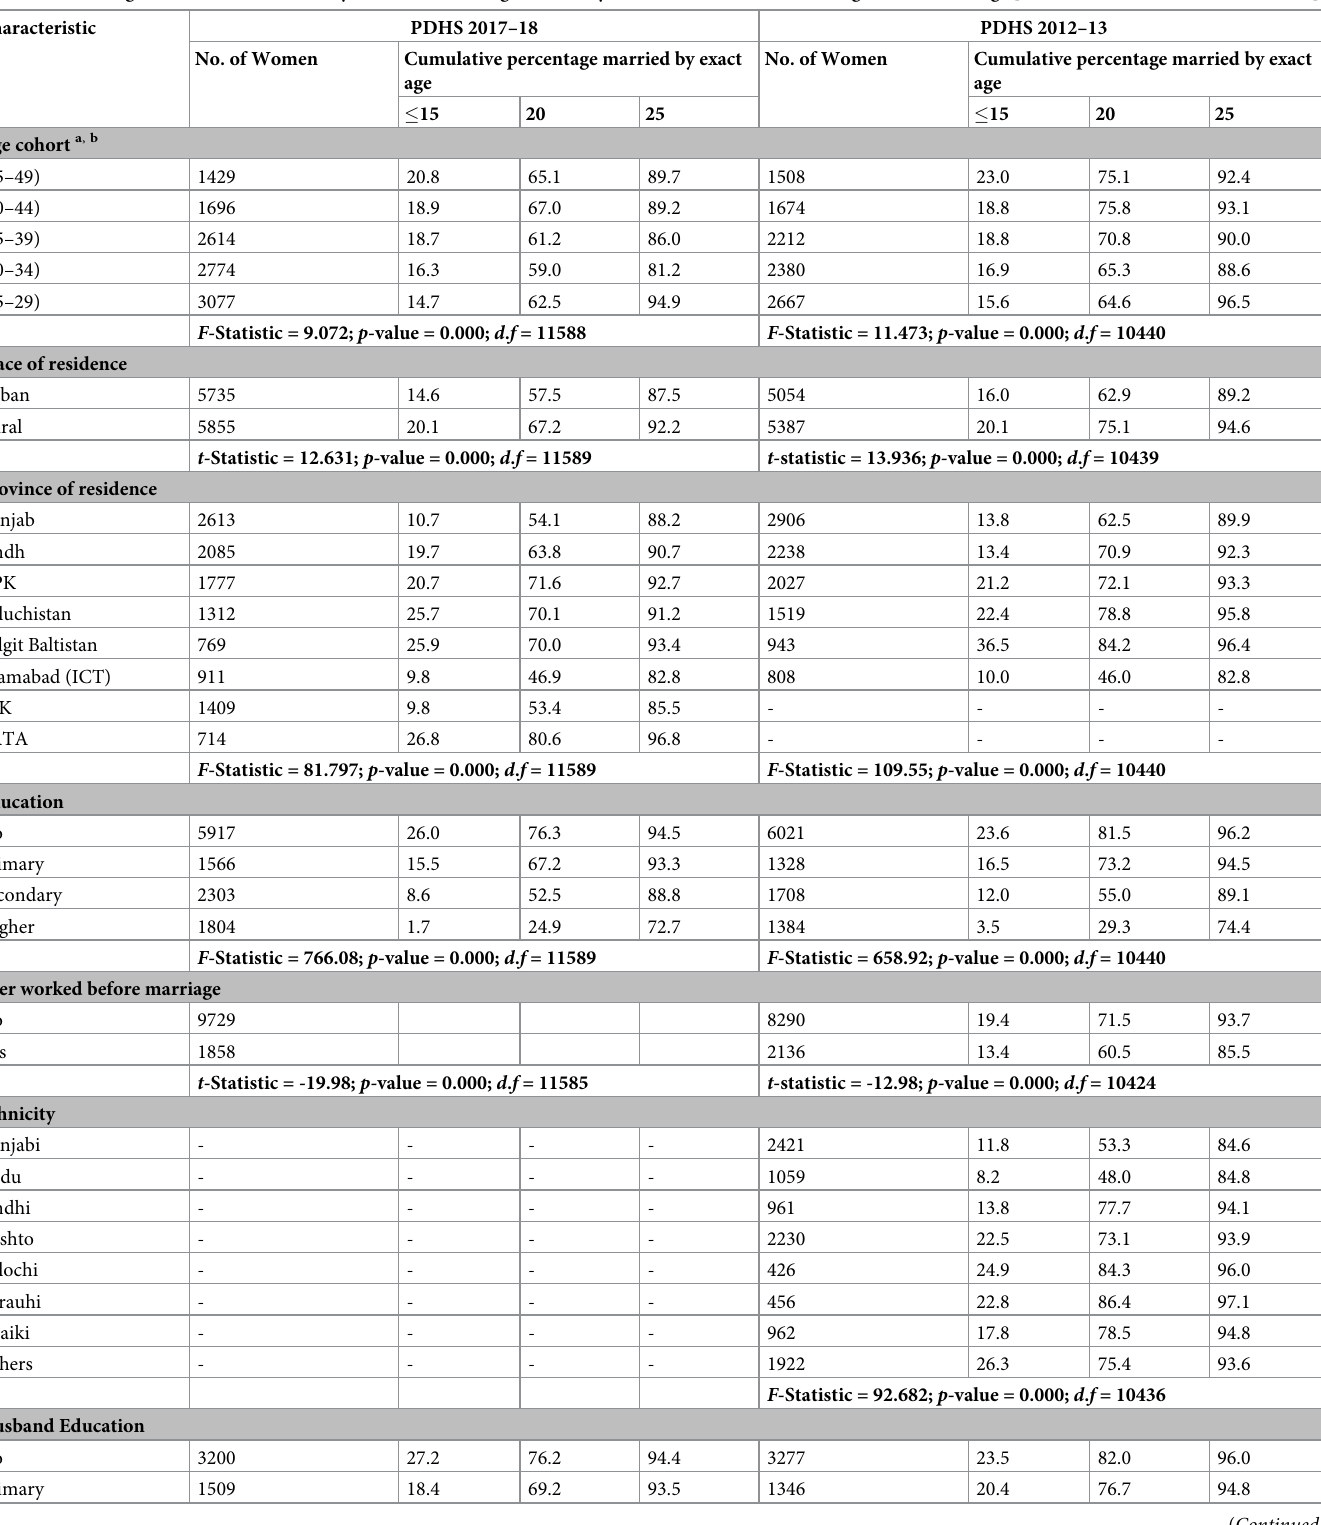
Table 5. Percentage distribution of currently married women aged 25–49 by various characteristics with age at first marriage [PDHS 2012–13 and PDHS 2017–18].